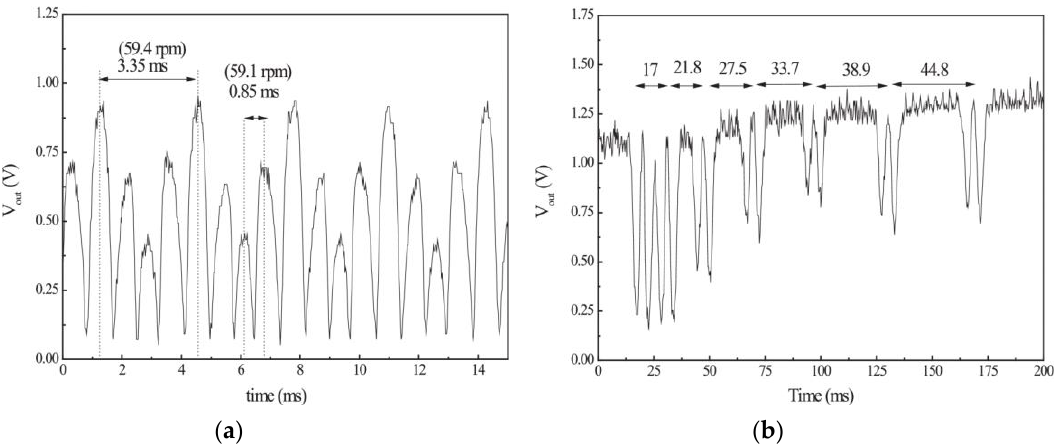
Figure 20. Envelope functions providing the angular velocity ( a ) and motion direction ( b ). The nominal rotary speed is 60 rpm. From [30], reprinted with permission.